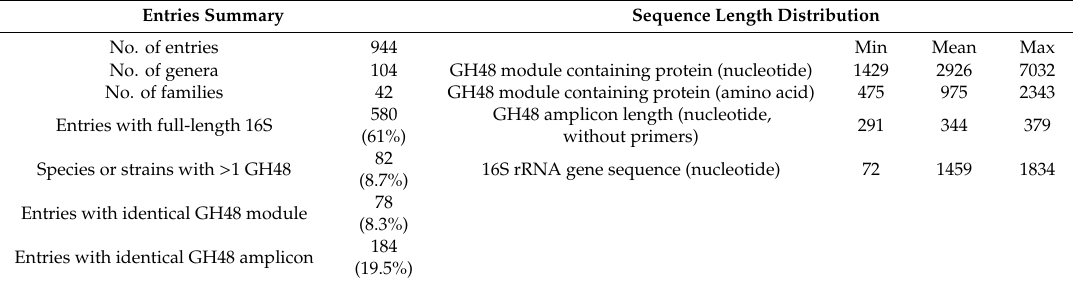
Table 5. Parameters of the GH48